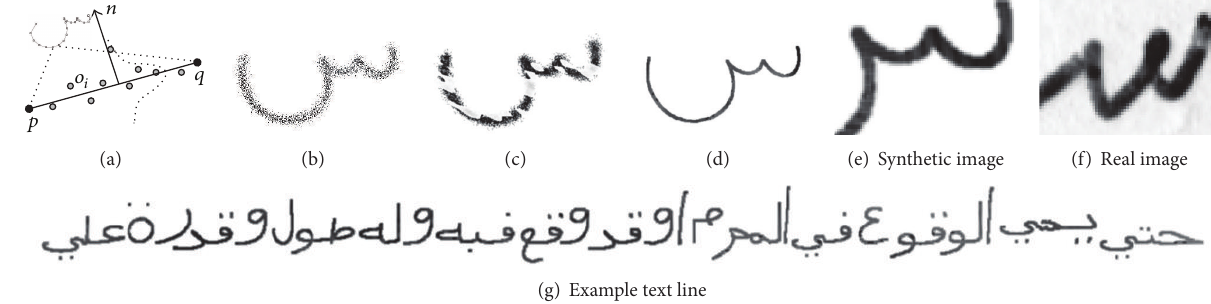
Figure 10: Painting technique: (a) scheme, (b) word shape with 𝜌 = 6, 𝜎 = 3 . 5 (Gaussian filter is disabled), (c-d) example results for painting technique: (c) test texture applied on (b), (d) 𝜌 = 30, 𝜎 = 1 . 0 with ball pen texture, and (e-f) comparison of natural and synthetic ball pen